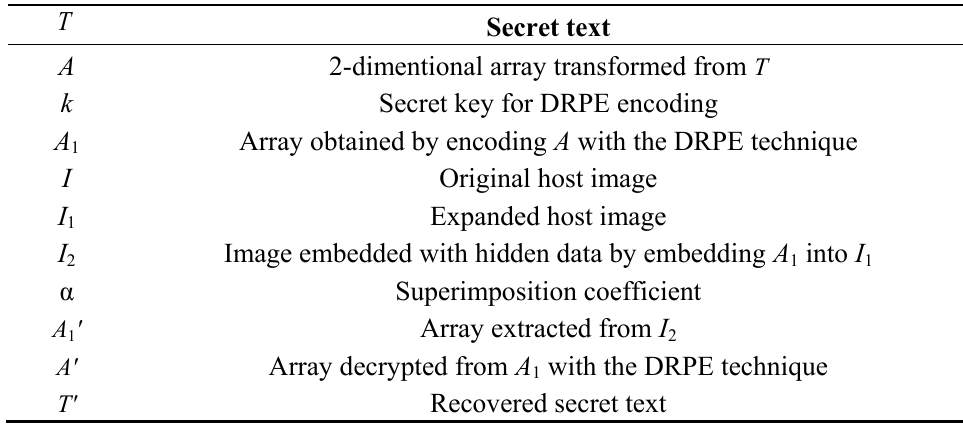
Table 1. Symbols used in the paper.